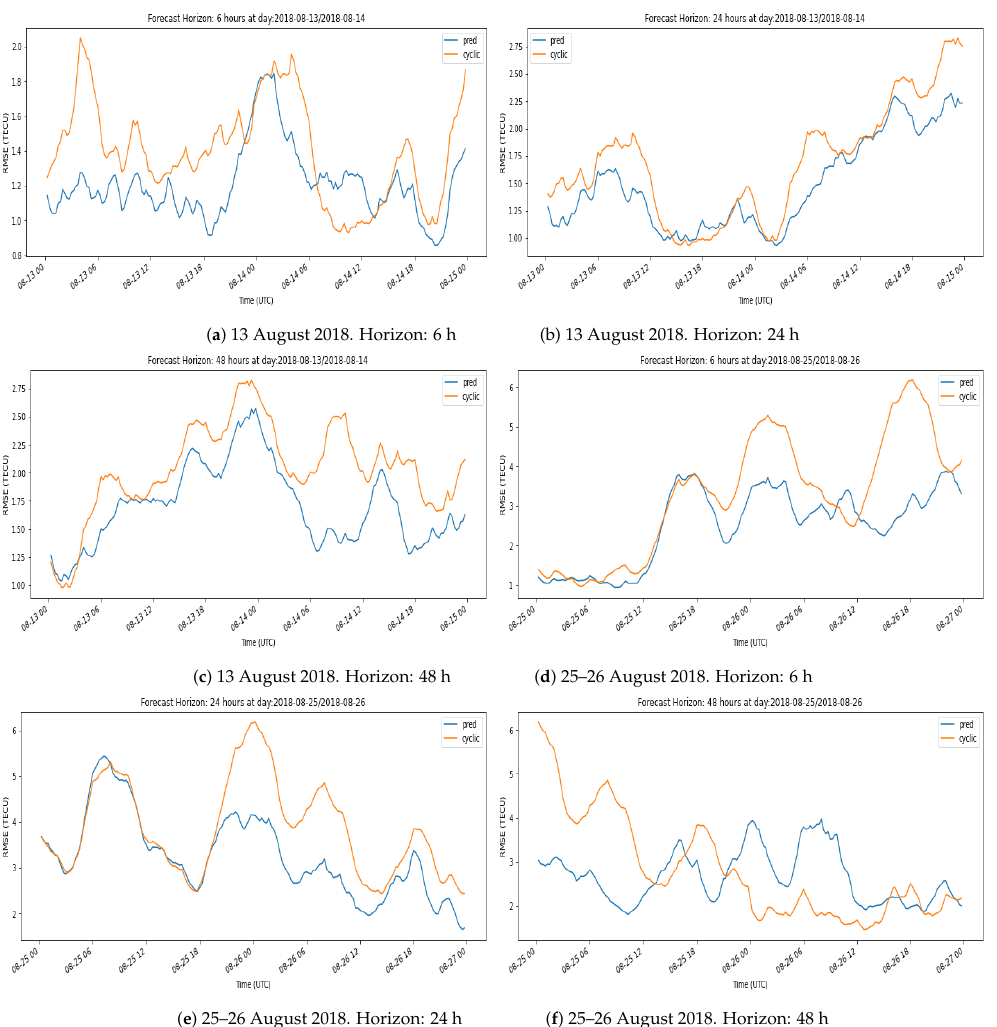
Figure 9. Comparison of the NNGIM forecast vs. frozen cyclic RMSE. Upper row: 13–14 August 2018 (12 days before the storm). Lower row: 25–26 August 2018 (storm